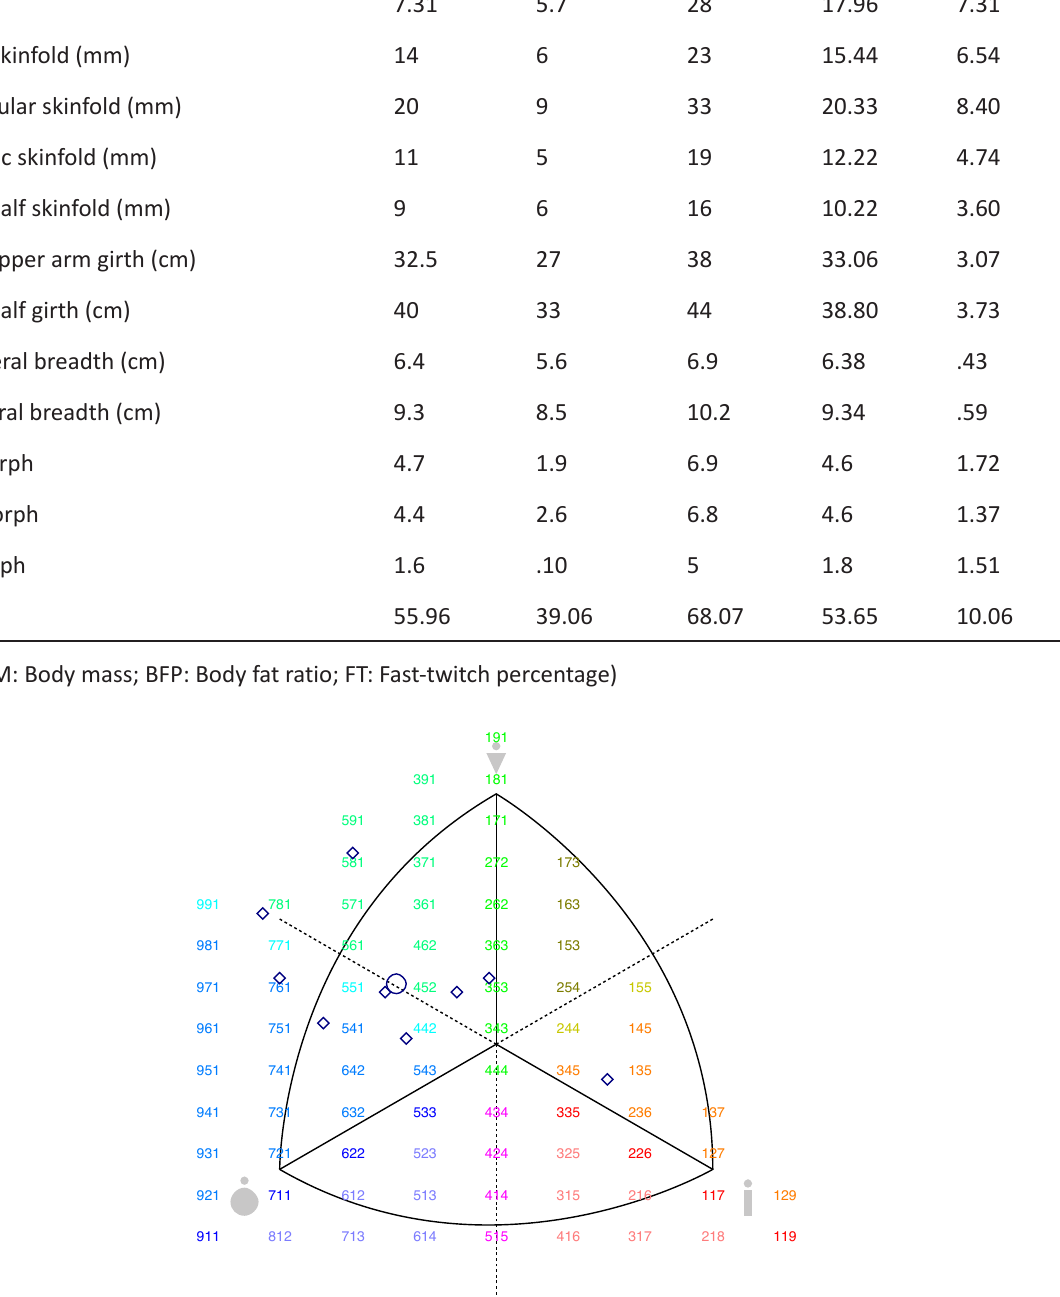
Figure 1. Somatotype distribution of participants (n=9) and mean somatoplot for all participants (red